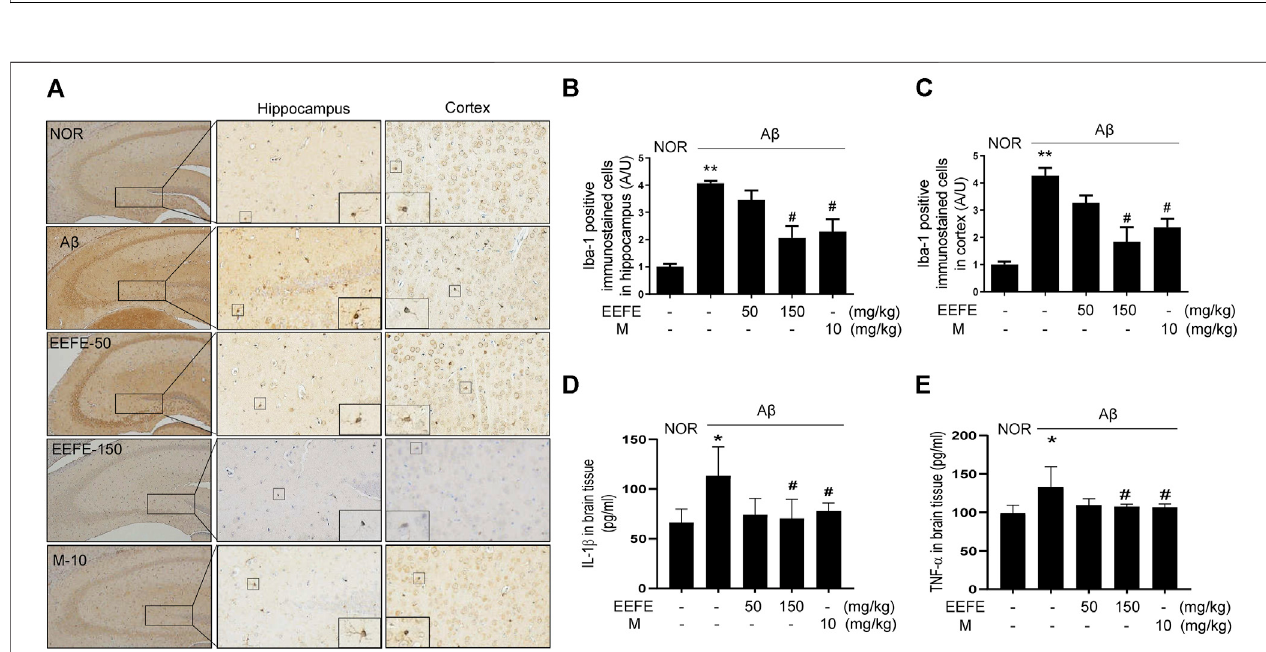
FIGURE 7 | Effects of EEFE on the neuroin fl ammation in A β -injected mice. (A) Multiple 4- μ m paraf fi n sections of hippocampus and cortex regions were prepared from the sacri fi ced mouse brains ( n (cid:1) 3/group). Expression of Iba-1, known as marker of microglical activation, was determined by immunohistochemistry with Iba-1 antibody in hippocampal and cortex region of brain sections. (A) Images were captured using a microscope at 400 x magni fi cation (Olympus DP71). (B, C) Quantitative analysis of Iba-1 positive immunostained cells was performed in hippocampal (B) and cortex (C) regions of brain sections. Square boxes indicate the magni fi ed pictures of Iba-1 positive cells. The staining intensities are reported in arbitrary unit (AU). The data are presented as the mean ± SD ( n (cid:1) 3/group). (D, E) Levels of in fl ammatory cytokines IL-1 β ( n (cid:1) 4/group) and TNF- α ( n (cid:1) 4/group) in brain lysates were determined using ELISA kits according to the manufacturers ’ instructions. The dataofthreeindependentexperimentsareexpressedasmean ± SEM.* p < 0.05or** p < 0.01vsNORgroupand# p < 0.05vsA β group.A β ,A β 1 – 42 – injectedmice;EEFE, ethanol extracts of Ficus erecta ; M, morin; NOR: normal control mice.